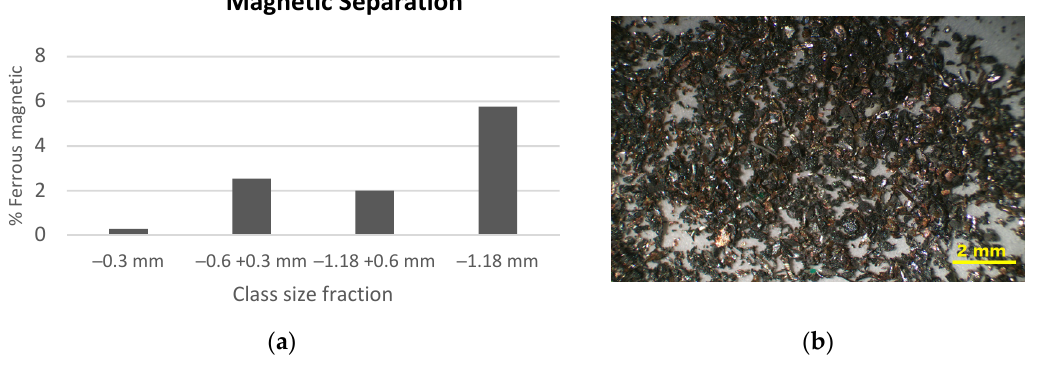
Figure 3. Quantity in % of ferromagnetic metals separated by the different class size ( a ); The magnetic separation results for the particle size class − 0.3 mm ( b ).